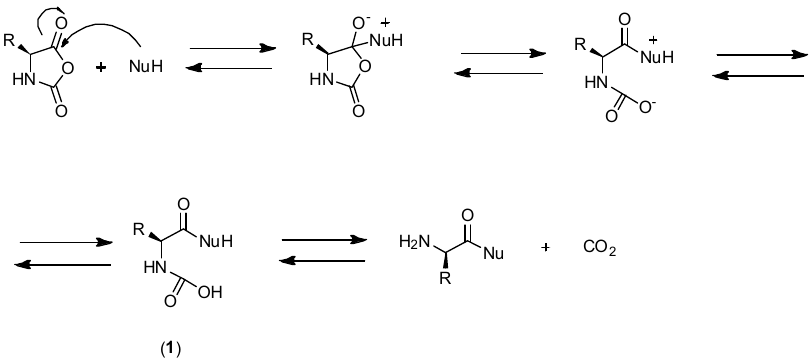
Figure 8. Polymerization via the “amine mechanism” (also called the “protic mechanism”) reported by Wessely and by Watson et al. [57]. Polymers 2017 , 9 , 551